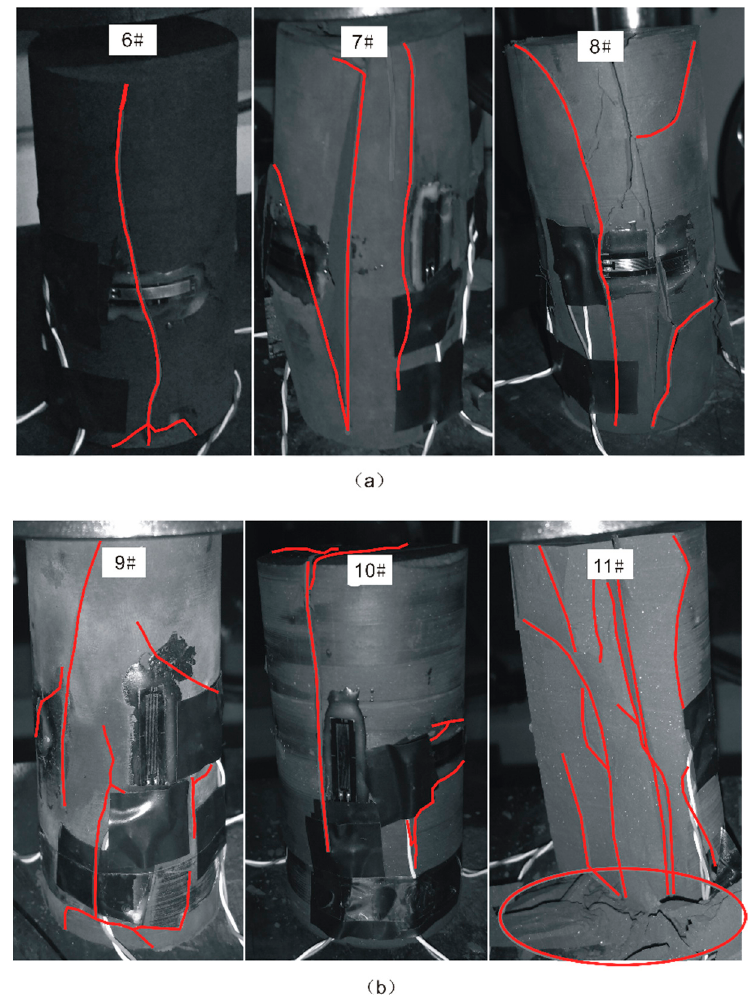
Figure 9. Failure modes of shale samples under uniaxial compression test: ( a ) Carbonaceous shales; ( b ) Siliceous shales.